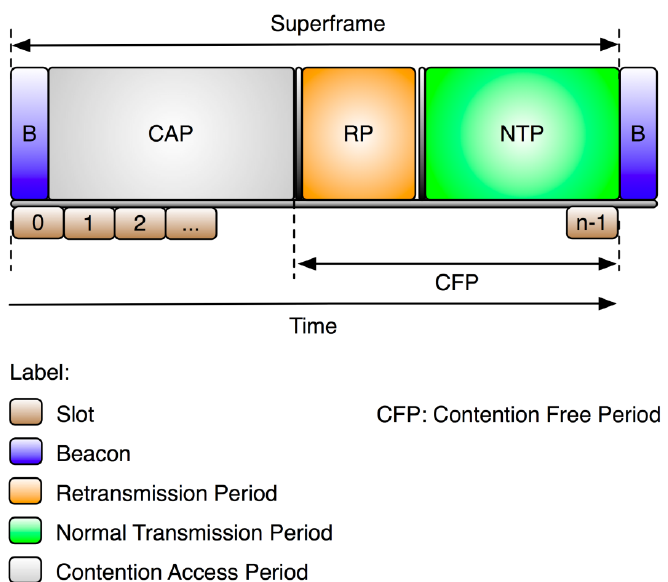
Figure 3. Superframe structure of the eLPRT